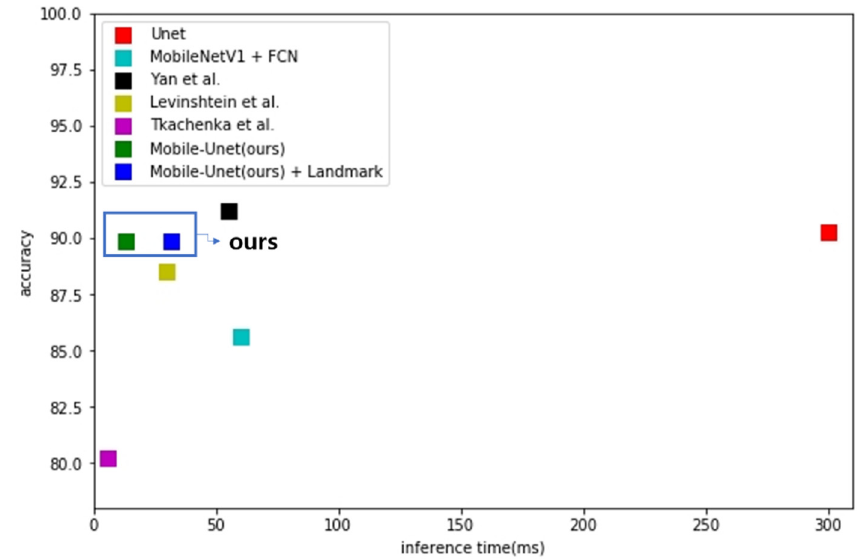
Figure 8. Comparison of the proposed Mobile-Unet method’s performance.